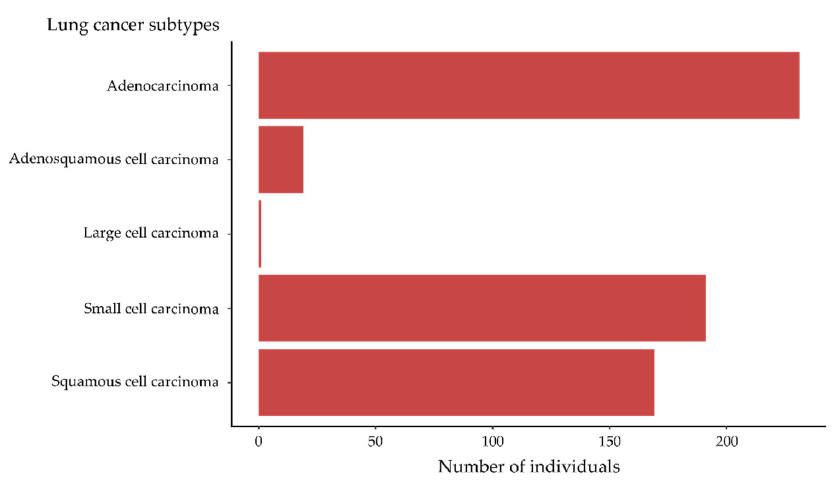
Figure 5. Tumor subtypes in LuCa.